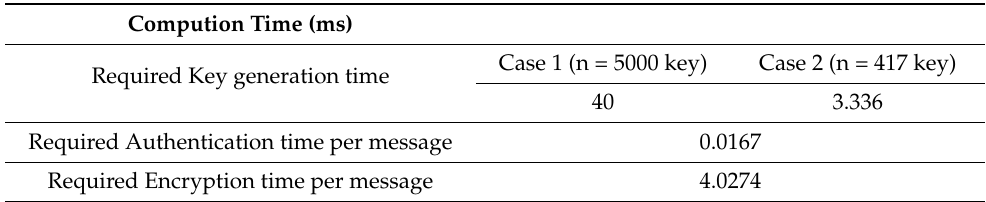
Table 5. The compution time calculation of the proposed key mangment protocol at the end